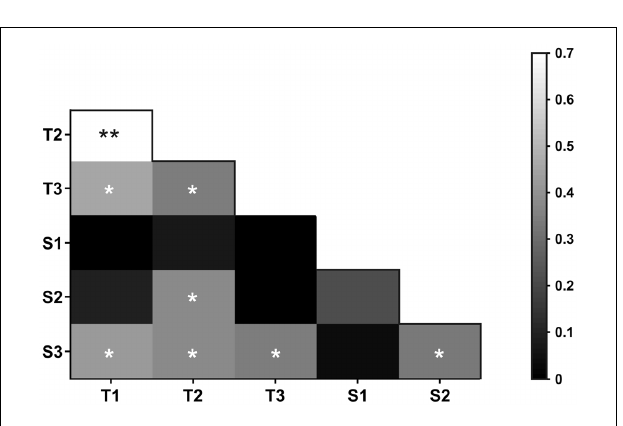
FIGURE 3 | Correlation matrix showing the Pearson R value in a grayscale (inset, right) for all possible pairwise block comparisons. Asterisks indicate significant correlations (* p ≤ 0.05, ** p ≤